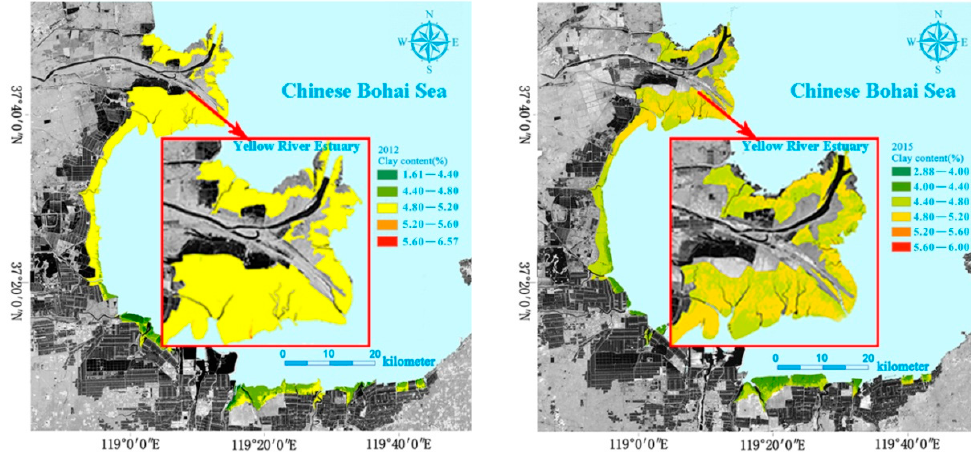
Figure 8. Spatial and temporal distribution of clay content from 1989 to 2015.